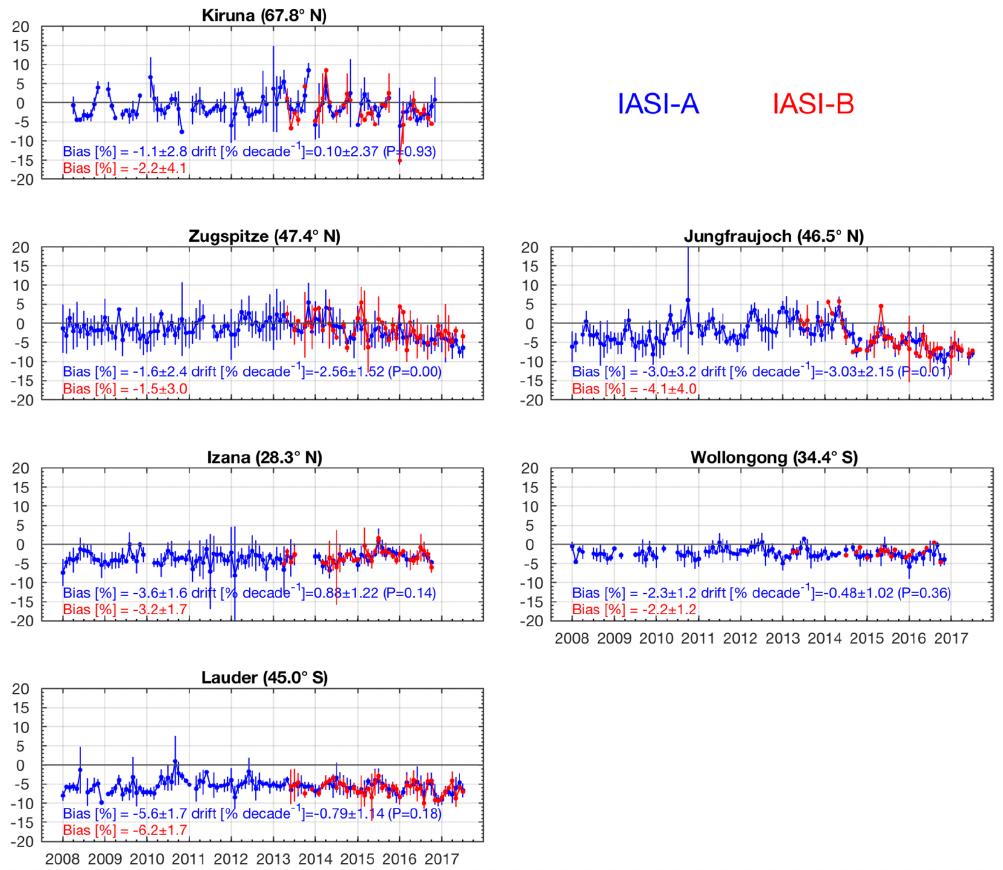
Figure 12. Time series of the monthly relative differences (in percent) between IASI-A (blue) and IASI-B (red) against collocated FTIR TOC measurements for six stations from north to south over the period from 2008 to July 2017. For each daily FTIR measurement, a relative difference is calculated as 100 × (IASI − FTIR) / FTIR [%]. All the relative differences are then monthly averaged. The standard deviation of the average is also displayed (vertical bars). Comparison statistics including the mean bias and its 1 σ standard deviation (in percent) for the period from 2008 to 2017 (IASI-A) and 2013 to 2017 (IASI-B) are indicated on each panel. The decadal drift, its 2 σ standard deviation (in percent) and the P value for the IASI-A time series are also indicated on each